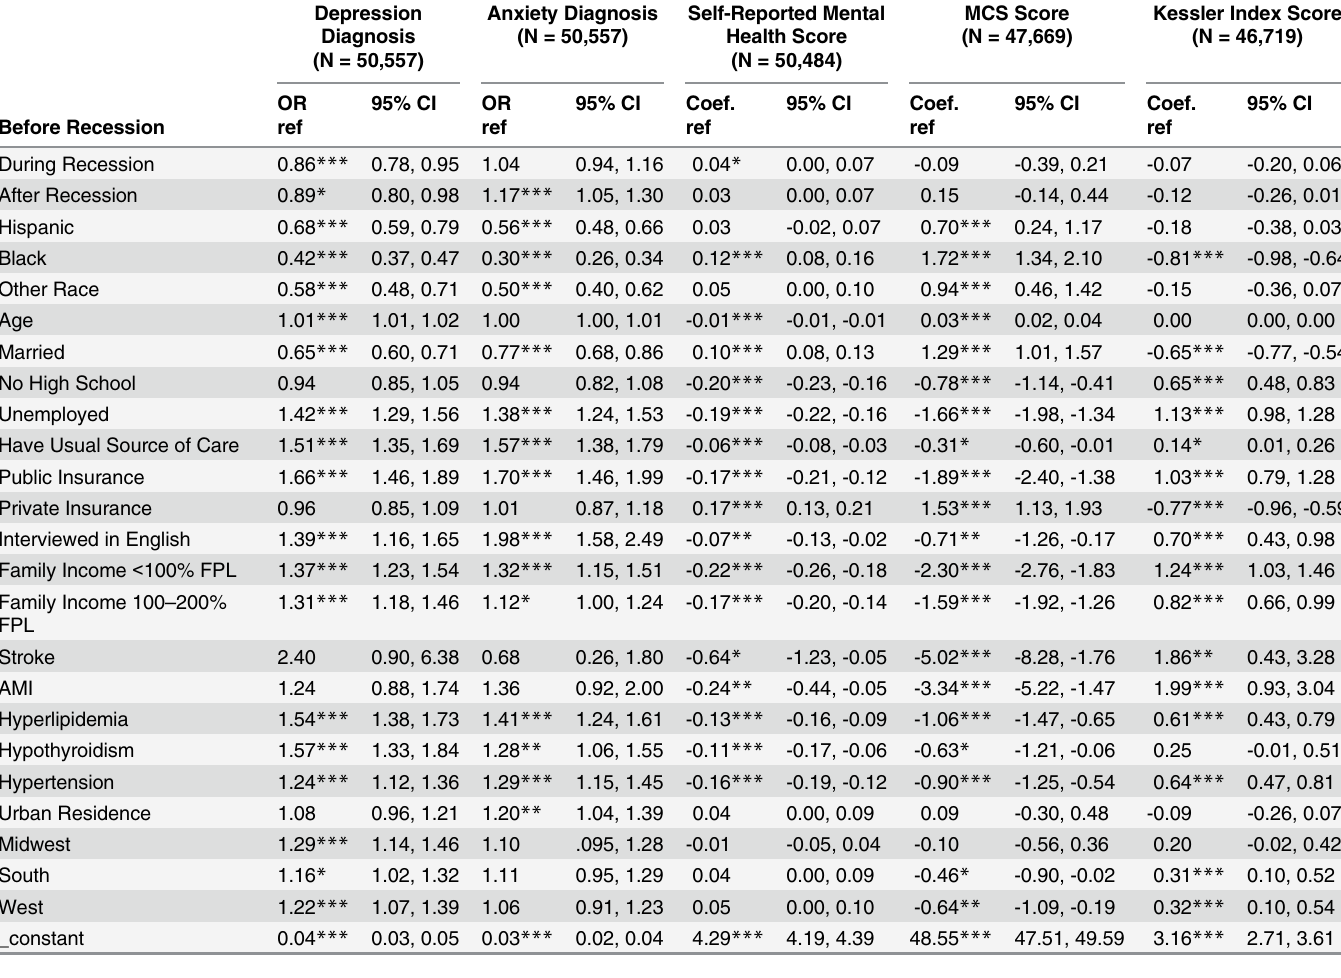
Table 2. Multivariate analyses of the associations between recession indicators (during and after) and mental health outcomes for